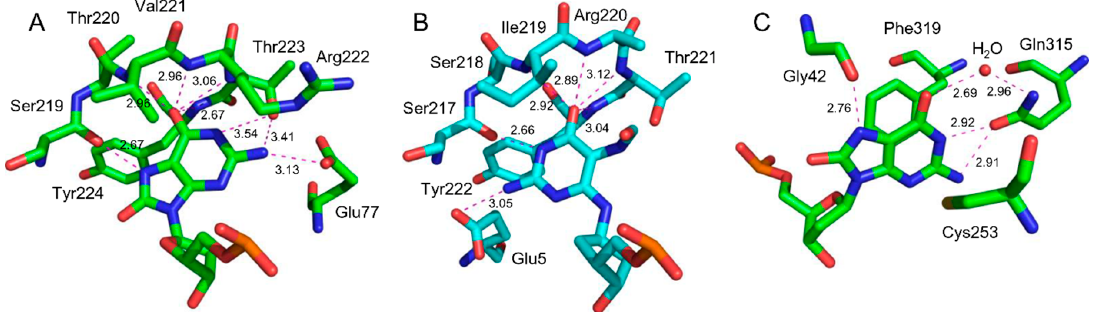
Figure 4. Recognition of oxidative lesions by 8-oxoguanine-DNA glycosylases. ( A ) G. stearothermophilus Fpg recognizing oxoG in the syn orientation (1R2Y) [103] . ( B ) L. lactis Fpg recognizing FapyG in the anti -orientation (1XC8) [106]. ( C ) human OGG1 recognizing oxoG in the anti -orientation (1EBM) [110]. Only the damaged nucleotide and the residues in its immediate vicinity are shown. Numbers indicate the distances between putative hydrogen bond donors and acceptors; note that only two of the possible four hydrogen bonds with O 6 (A, B) can exist at any given moment.